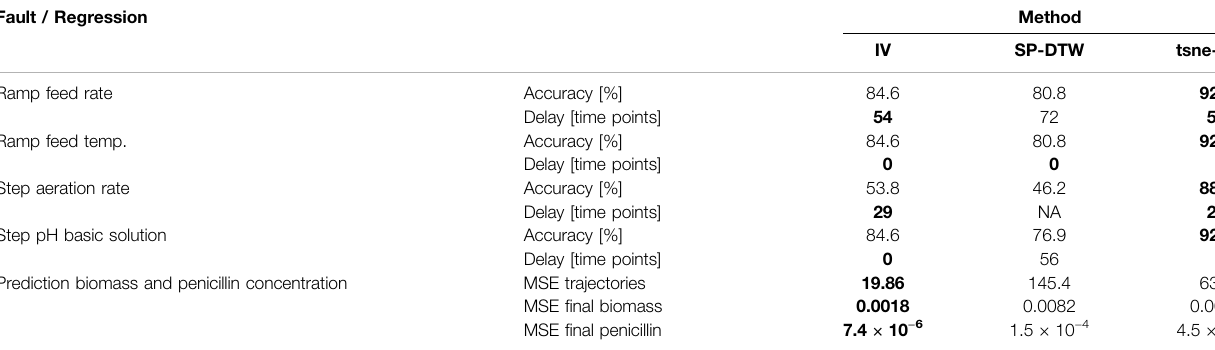
TABLE 1 | Process monitoring applications on the Pensim process using different methods for phase identi fi cation and alignment. Fault / Regression